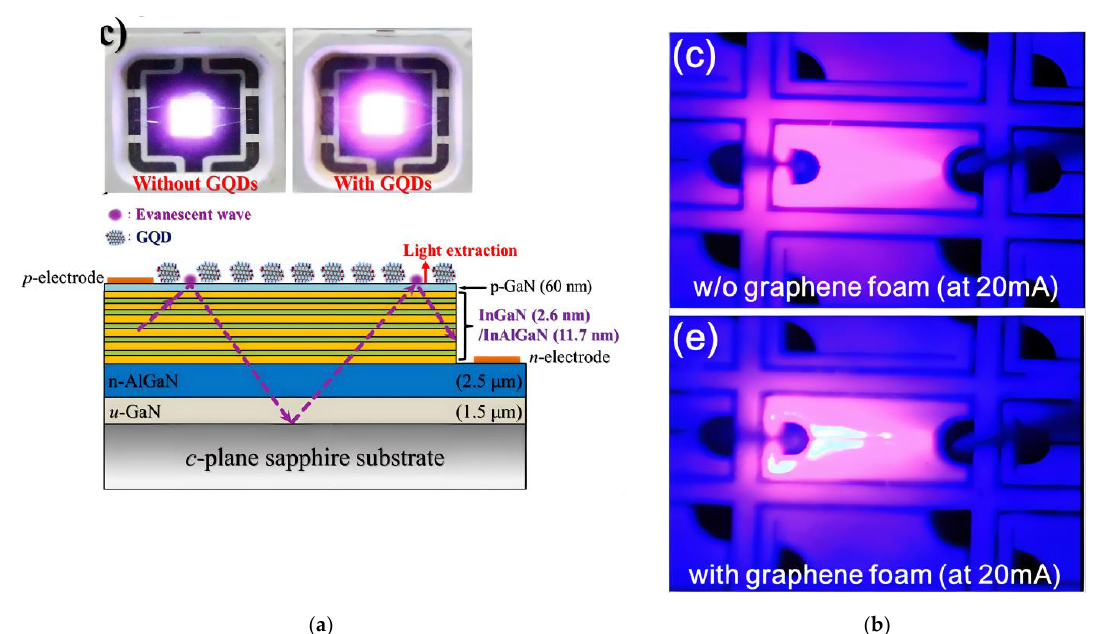
Figure 5. 0D GQD as top layer and 3D graphene foam as TCSL integrated into GaN-based MQW LEDs: ( a ) The upper part is the optical image of an operating LED device without (left) and with 0D graphene GQD (right). The lower part illustrates a schematic cross-sectional view. The violet arrow denotes the direction of the light propagation; ( b ) EL images in a LED device without (upper) and with (lower) graphene foam. ( a ) Reproduced with permission from [45]. Copyright 2017 The Author(s), ( b ) Reproduced with permission from [46]. Copyright 2013 AIP Publishing